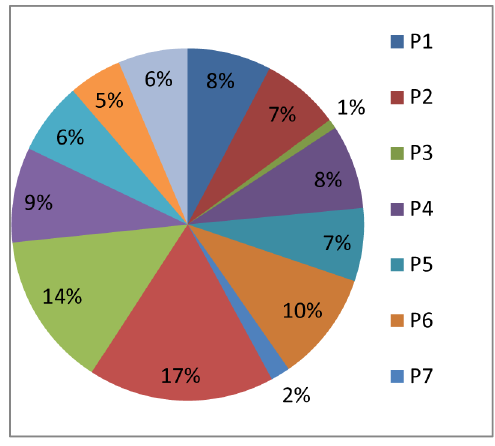
Fig. 2. Problem significance (Normalized values of criteria,